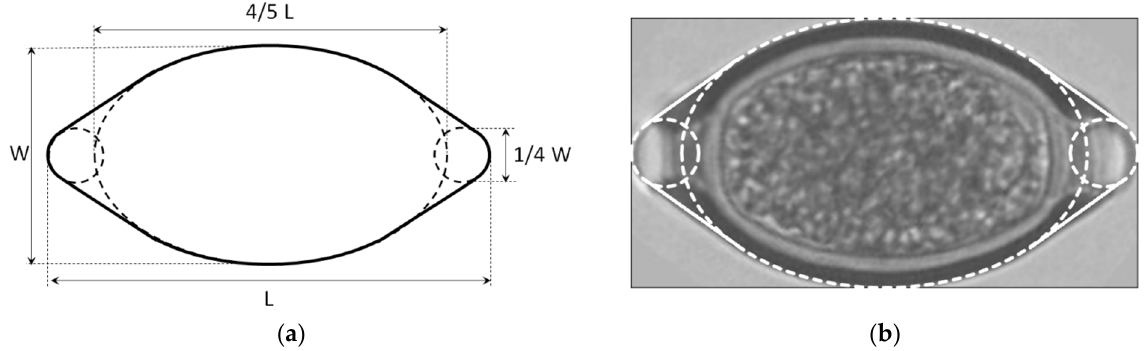
Figure 3. TRI, ( a ) idealized shape, ( b ) idealized shape compared with real